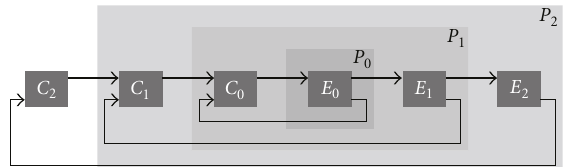
Figure 3: The signum definitions used in this work.